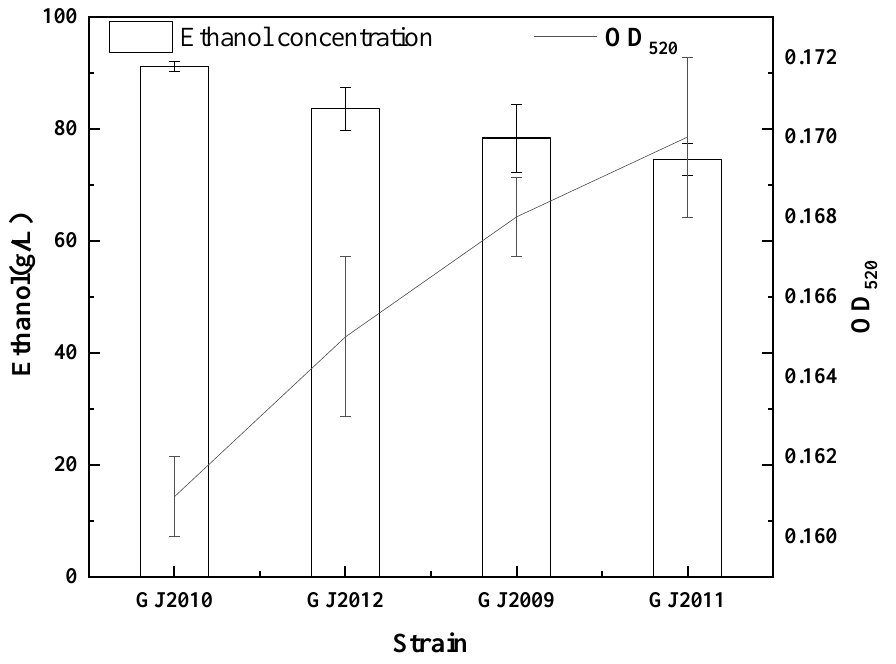
Figure 3. ( ☐ Ethanol concentration) Four S. cerevisiae strains, GJ2009, GJ2010, GJ2011, and GJ2012 (derived from GJ2008), with different ethanol synthesis capacities, were verified by fermentation under 190 g/L sucrose after 30 h. (-OD 520 ) 120 µL of these four S. cerevisiae strains’ fermentation supernatant (five times dilution) was transferred to a 96-well enzyme label plate and 80 µL 1M Fe(NO 3 ) 3 was added for reaction at room temperature for 10 min. Then the absorbance was meas- ured at OD 520 nm.